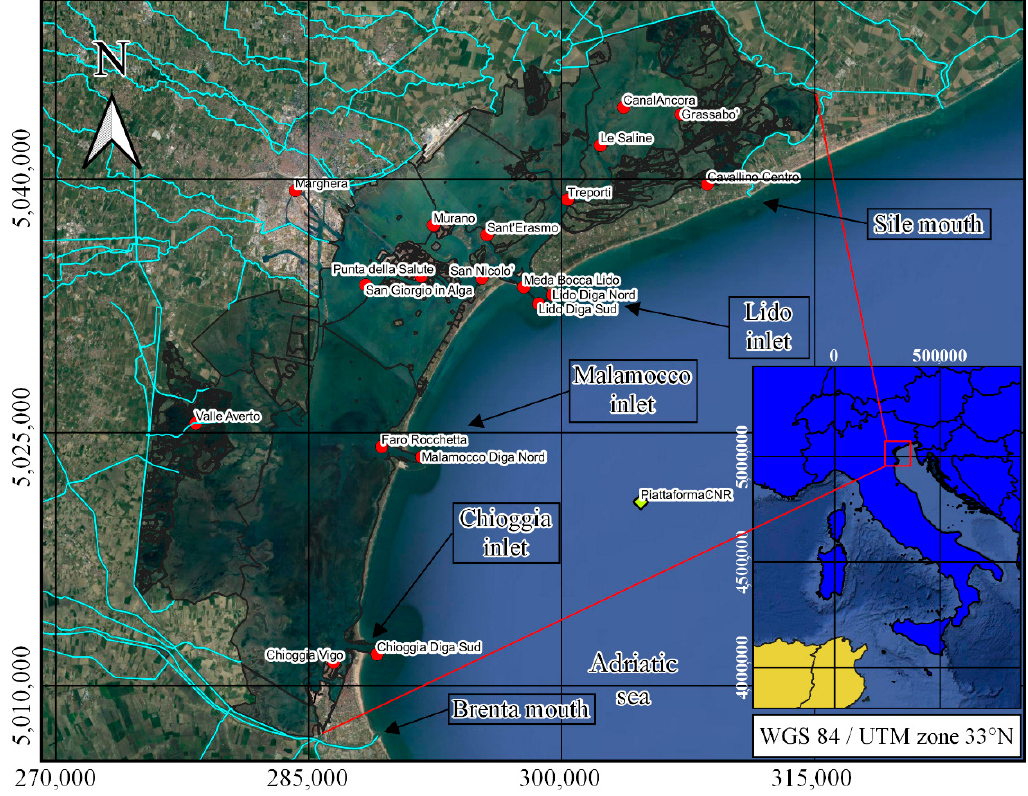
Figure 1. Location of the tide gauge ( • ) and weather station ( ♦ ), with a representation of the water-drainage network ( – ) on a satellite image of the Venice Lagoon.